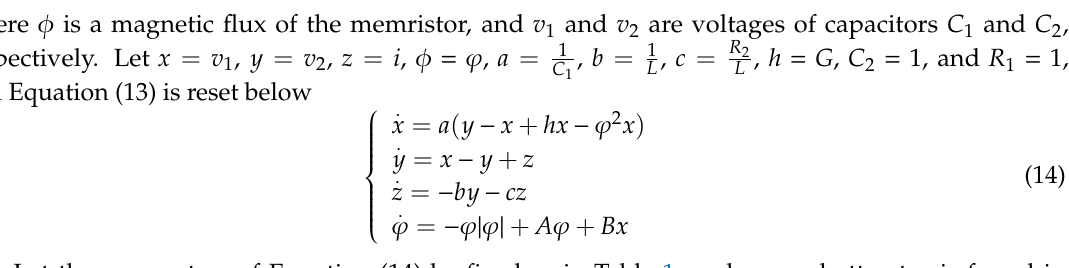
Figure 4. Pinched hysteresis loops of the AM emulator under the sinusoidal input voltage with the